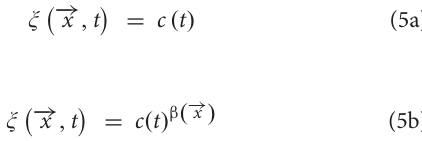
FIGURE 3 | Examples of leaflet kinematic features which can be obtained by tuning the mapping function, ξ : commonly observed opening mode shapes can be obtained using simple mathemtical dependencies such as (A) linear and (B) power relations between the mapping function and lumped